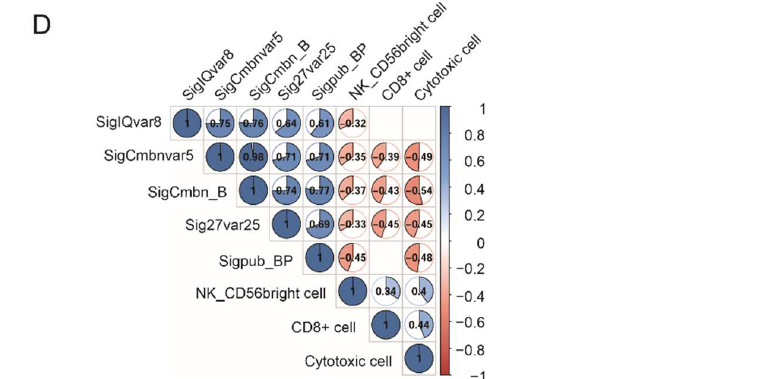
Figure 9. Correlations of multigene signatures with reductions of CD8+ and NK cells in ACC. ( A ) Immune cells were profiled using Xcell within the MSDIC R package, followed by the determination of the correlation of CD8+ T cells with Sig27var25 scores using the ggpubr R package (left panel). The Sig27var25 negative and positive ACC (boxplot, right panel) were defined with the cutoff point estimated using an empirical method (right panel). ( B , C ) NK CD56bright and cytotoxic cells in ACCs were profiled using ssGSEA within the MSDIC R package. ( D ) Scores from the indicated multigene signatures, NK CD56bright cells, CD8+ T cells, and cytotoxic cells were used to construct the Spearman correlation image with the corrplot R package. Correlations with p < 0.01 are included. * p < 0.05; ** p < 0.01.